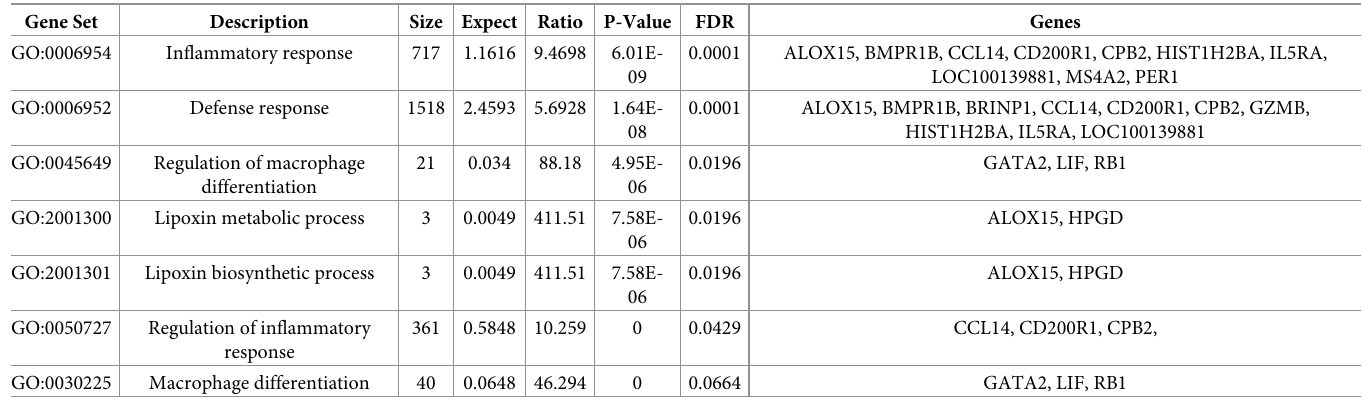
Table 1. Significantly enriched biological processes (GO-BP) with associated DEGs in cattle at arrival. Gene